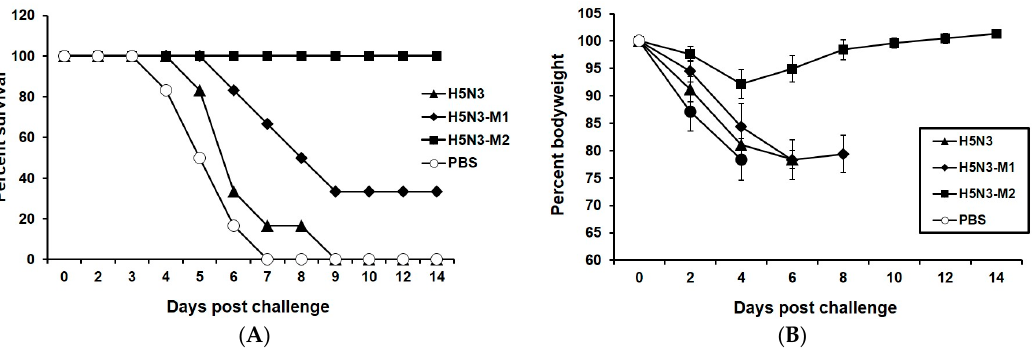
Figure 3. Protection of mice from lethal H5N1 virus challenge. Mice ( n = 6/group) were subcutaneously immunized on days 0 and 28 with RG-H5N3 or RG-H5N3HA M1 or RG-H5N3HA M2 viral vaccine and PBS. Four weeks after the second vaccination, mice were intranasally infected with 5 50% mouse lethal dose (MLD 50 ) of a clade 2.3.2.1 H5N1 (RG-A/Hubei/1/2010) strain on day 49. Mice were monitored for survival for 14 days and the results were expressed in percent survival ( A ). Weight loss of the mice groups was also monitored throughout the 14-day observation period and the results were expressed in percent body weight compared to the start of the viral challenge ( B